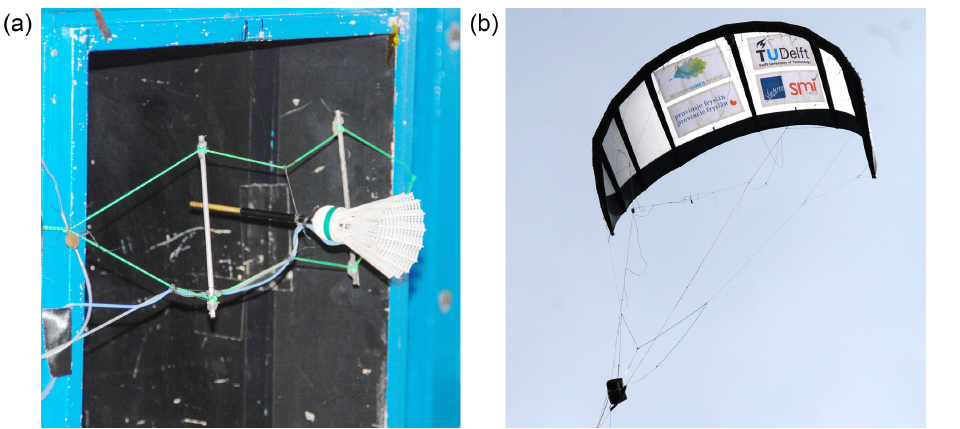
Figure 1. Pitot tube during calibration in the wind tunnel ( a ) and suspended in the bridle line system of a remote-controlled 25m 2 LEI V2 kite during a flight test ( b